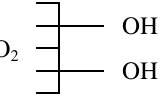
Figure 2. Scheme of activated silica 5